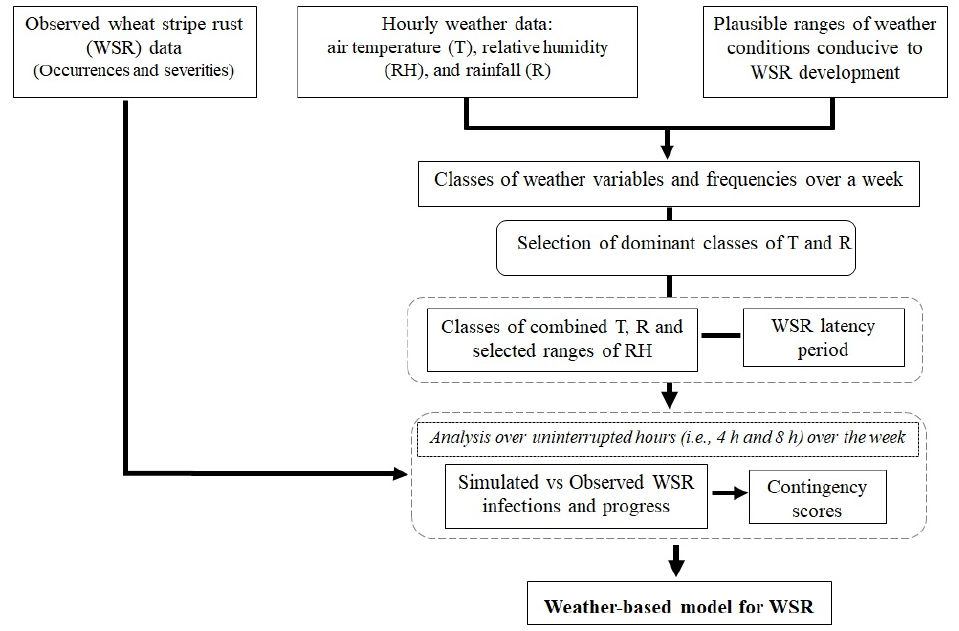
Figure 2. Descriptive flowchart of the modeling approach for predicting infection events of wheat stripe rust caused by Puccinia striiformis .